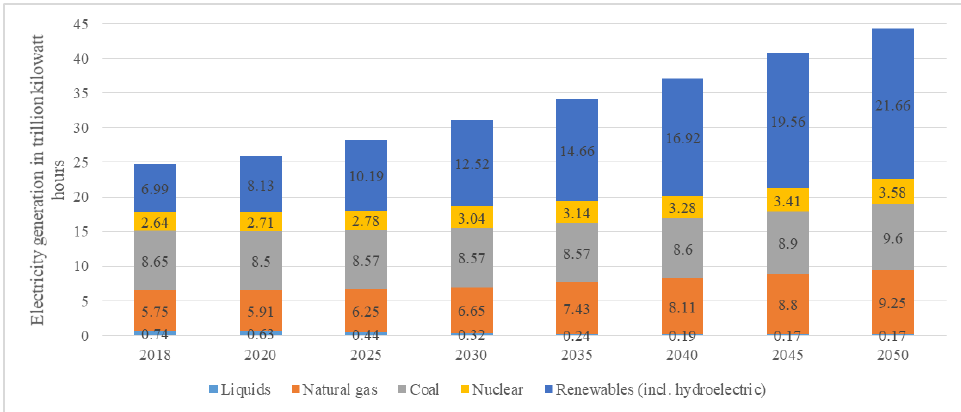
Figure 1. Forecast of worldwide electricity generation by different energy sources (in trillion kilowatt hours).